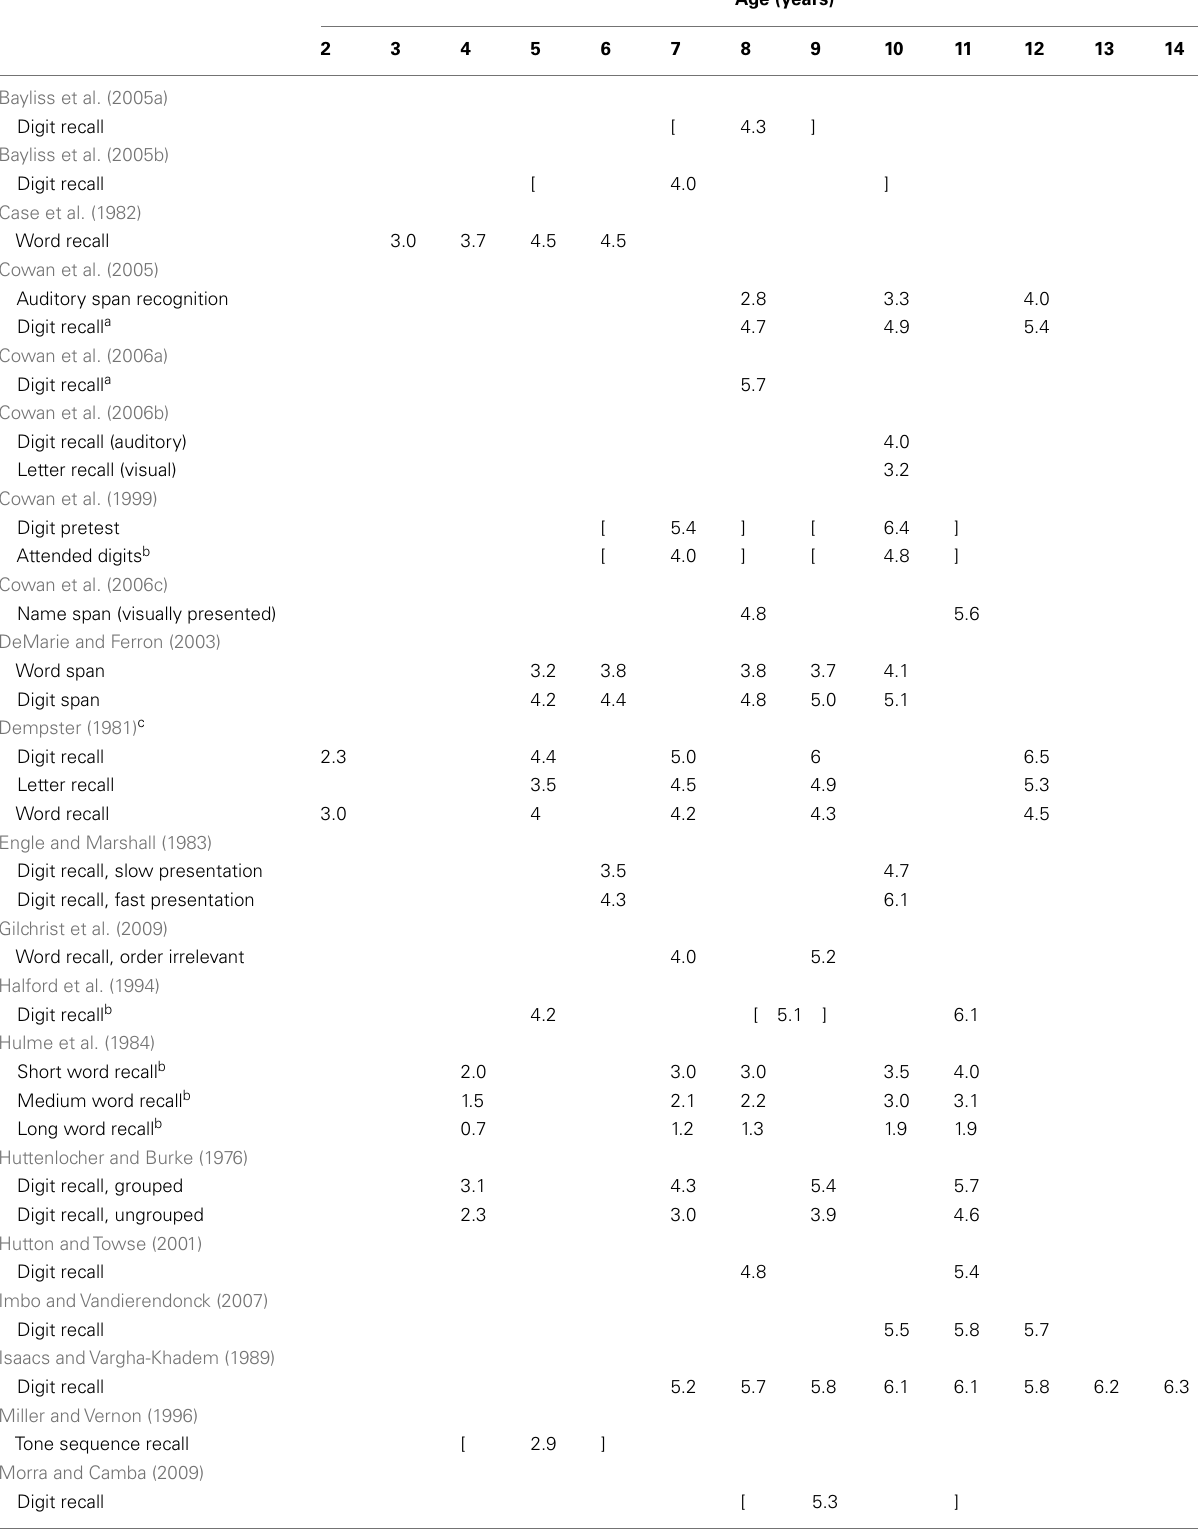
Table 1 | Estimates of verbal working memory capacity using simple span